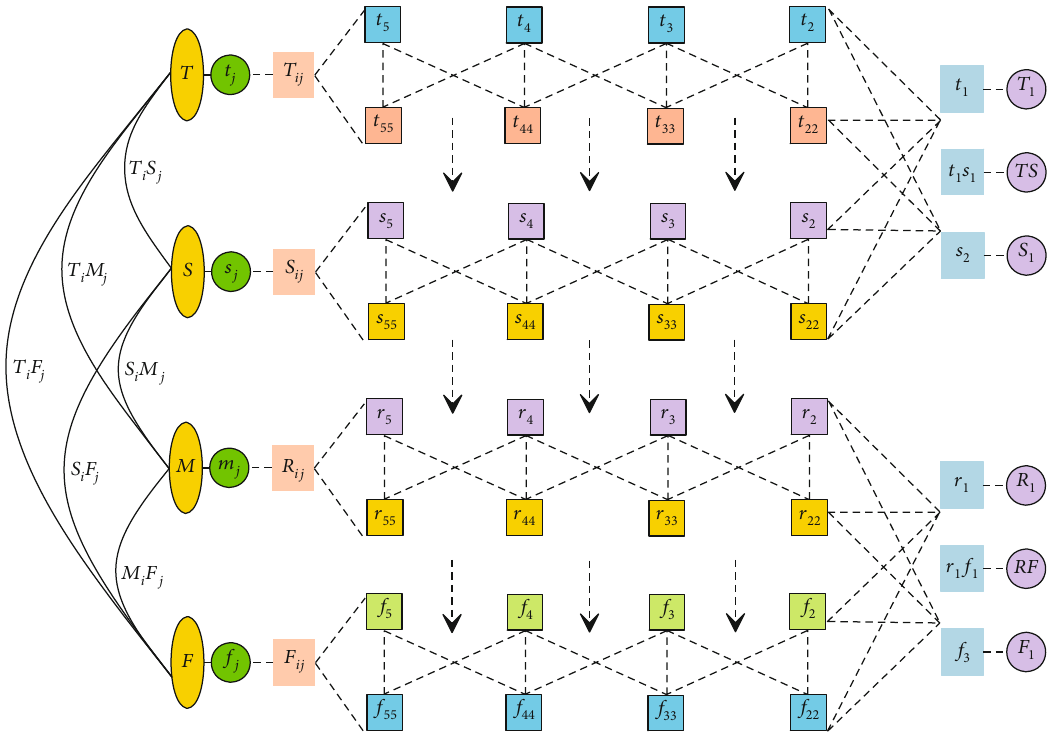
Figure 2: Analytical framework of the e ff ect of AI on role cognition in the education system in Taiyuan